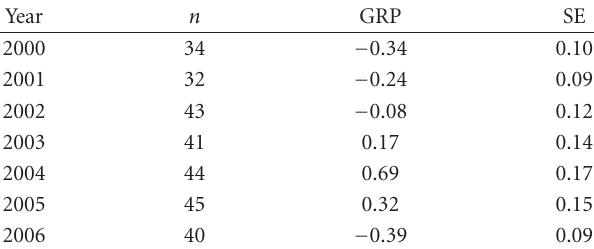
Table 2: Annual averages ( ± SE) of juvenile sockeye salmon growth rate potential (GRP; % body weight per day) during August– September 2000 to 2006 along the eastern Bering Sea shelf. The number of stations ( n ) are